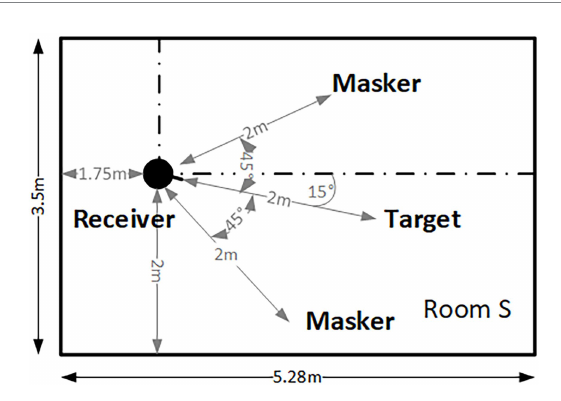
FIGURE 1 Illustration of the target, receiver, and masker positions in the small room. The same target-receiver-masker positions relative to the lower-left corner as the room origin were used in the anechoic and large room. Accordingly, the distance between the left masker and the upper wall increased from 0.5 m to 1.5